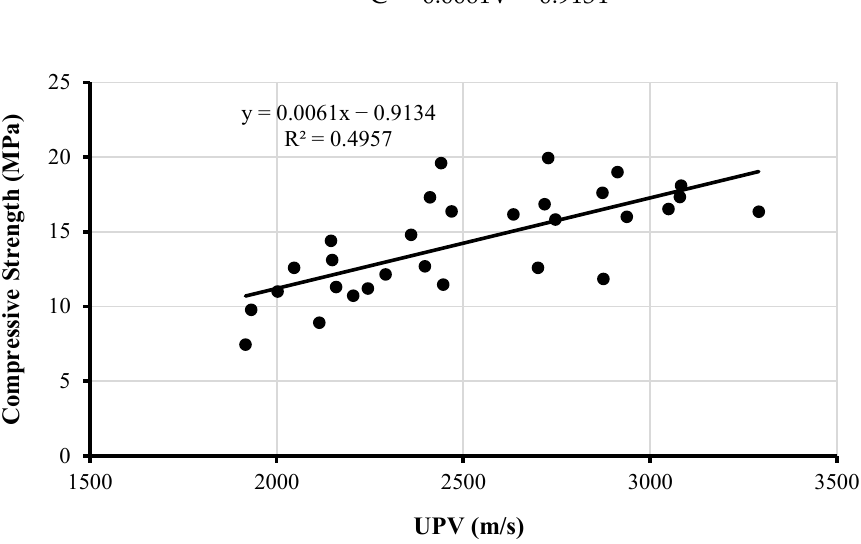
Figure 13. Old bricks combined data.